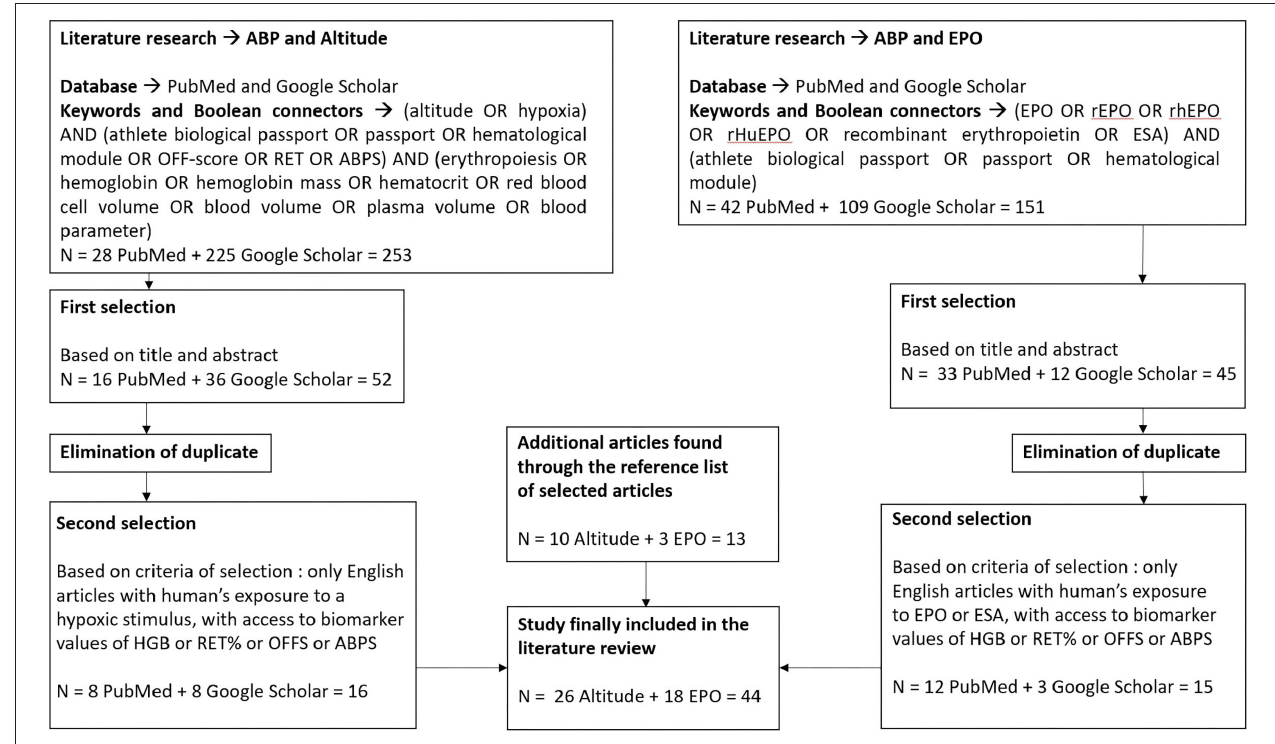
FIGURE 1 | Diagram of the literature search process. HGB, concentration of hemoglobin; RET%, reticulocyte percentage; Off-hr, stimulation index Off-score; ABPS, abnormal blood profile score; EPO, erythropoietin; rhEPO, recombinant human erythropoietin; ESA, erythropoiesis-stimulating agent; n , number of articles present at each